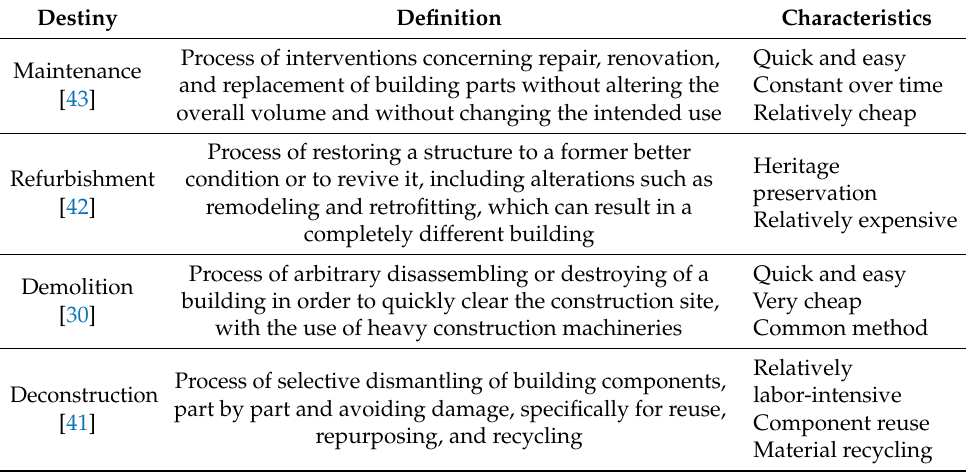
Table 1. Building’s end-of-life